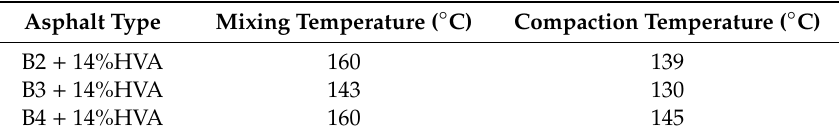
Table 5. Mixing and compaction temperature for di ff erent